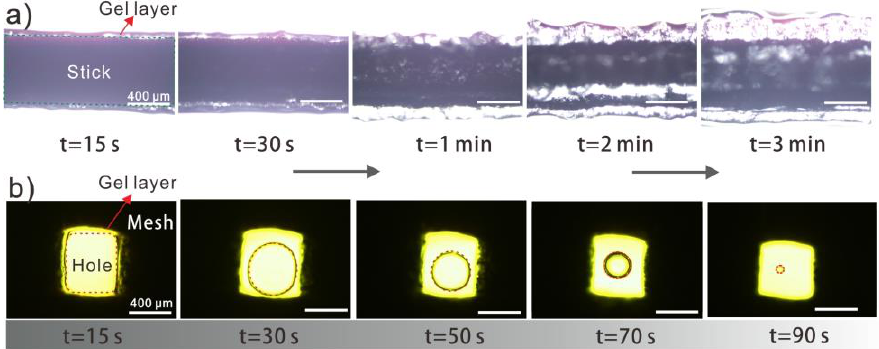
Figure 2. ( a ) The optical microscope photos of hydrogel coating growth on single Fe/PLA stick with reaction time. ( b ) The observation of hydrogel thickness increasing from approximately 50 to 400 μm until the pore is almost blocked, showing feasibility in controlling pore size.